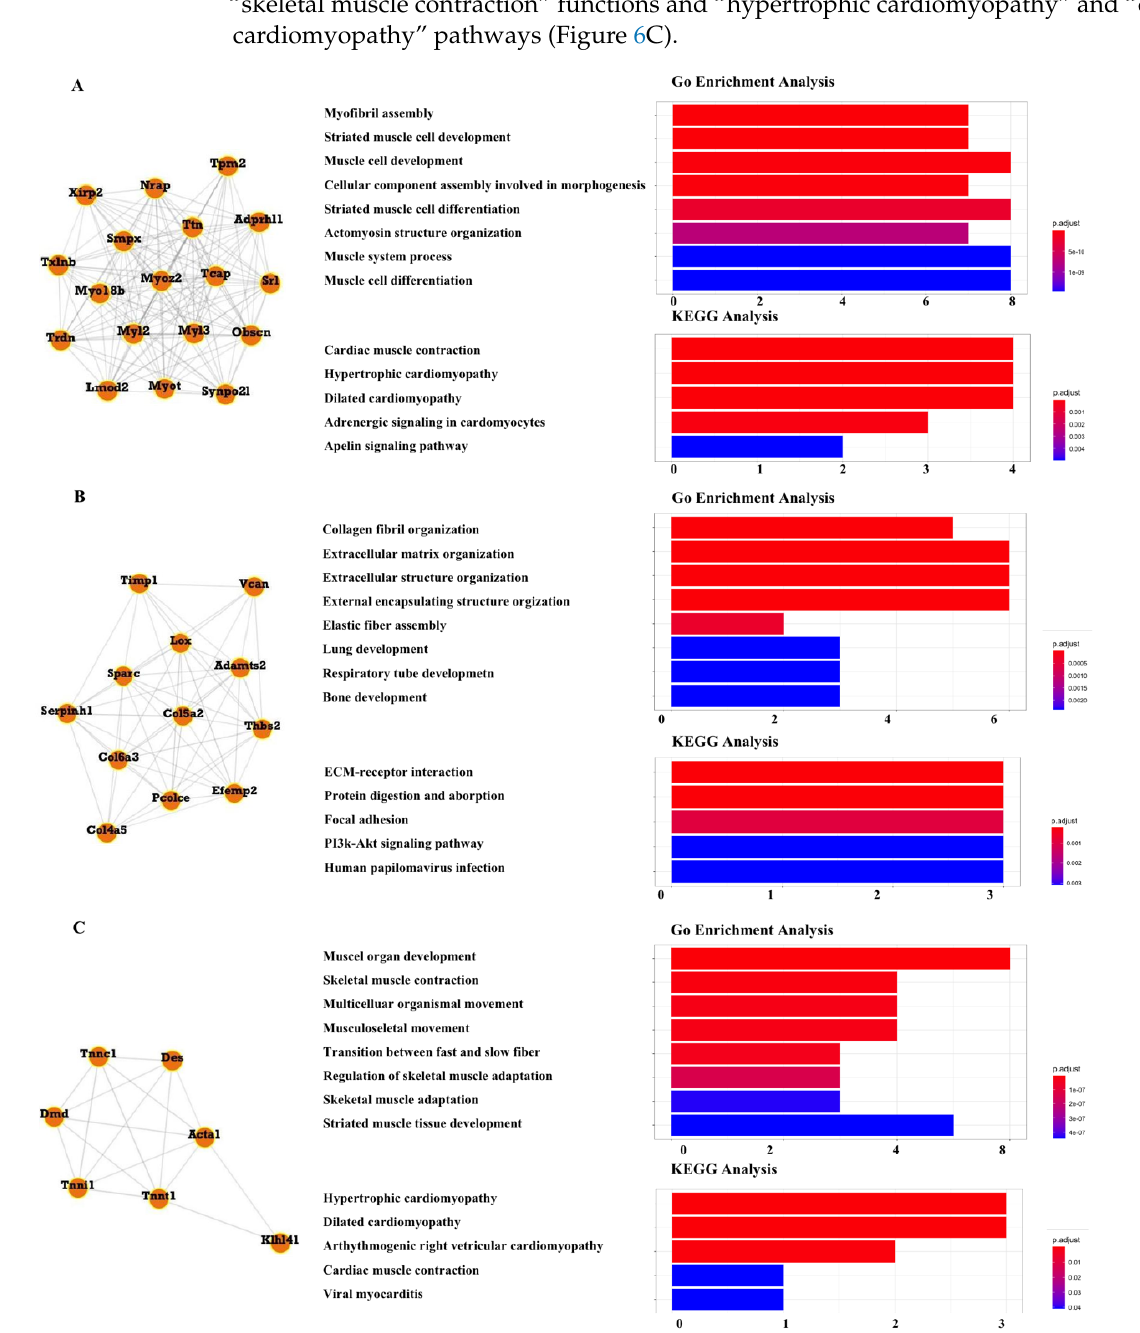
Figure 6. Module analysis. ( A ) Module 1 comprises 18 genes and is enriched in cardiac muscle contraction and hypertrophic cardiomyopathy. ( B ) Module 2 comprises 12 genes and is enriched in ECM–receptor interaction, protein digestion and absorption, and the PI3k-Akt signaling pathway. ( C ) Module 3 comprises 7 genes and is enriched in muscle organ development and skeletal muscle